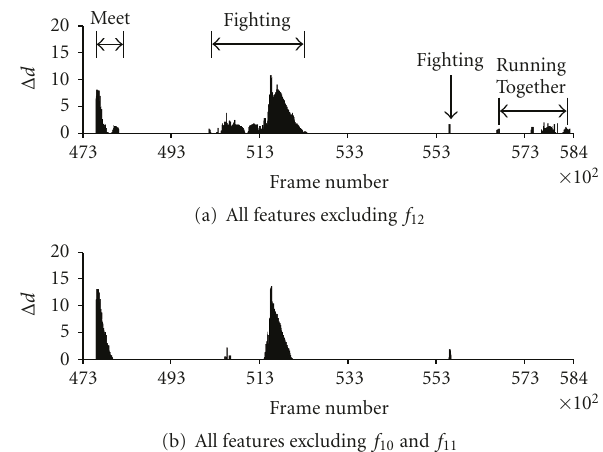
Figure 13: Detection results based on: (a) all features excluding f 12 ;